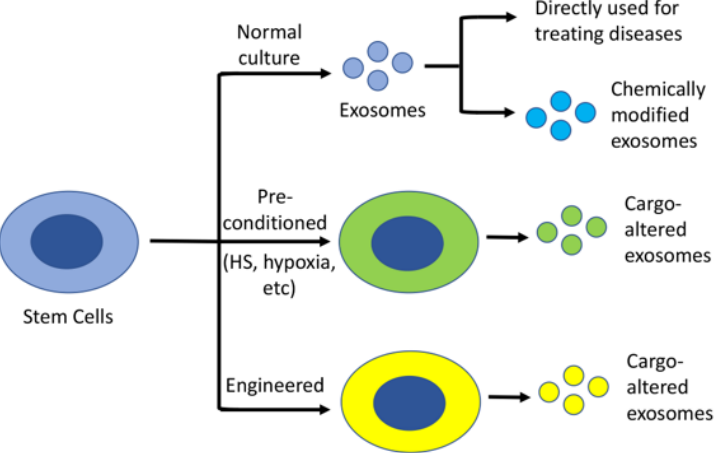
Figure 2. Stem cell-derived exosomes as a therapeutic agent. Stem cell-derived exosomes, without or with modification, can be used to treat various diseases. To increase the yield and/or therapeutic efficacy, the cells can be either pre-treated with a specific condition, such as HS or hypoxia, or engineered to overexpress a specific protein.